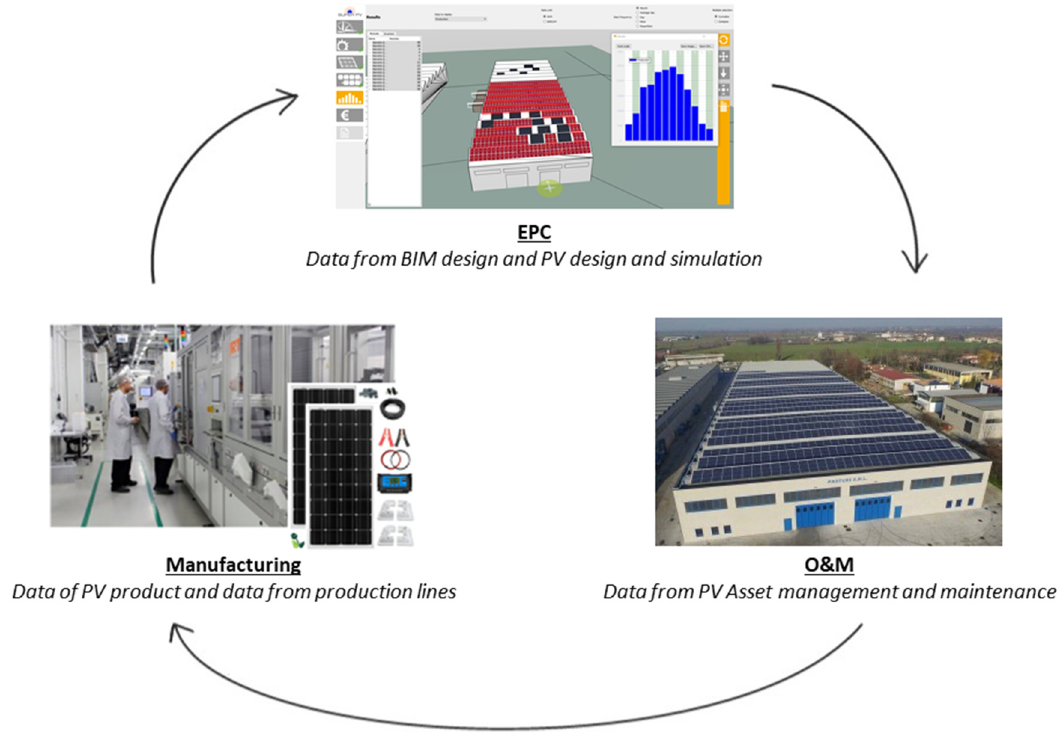
Fig. 2. Overview of the PIM